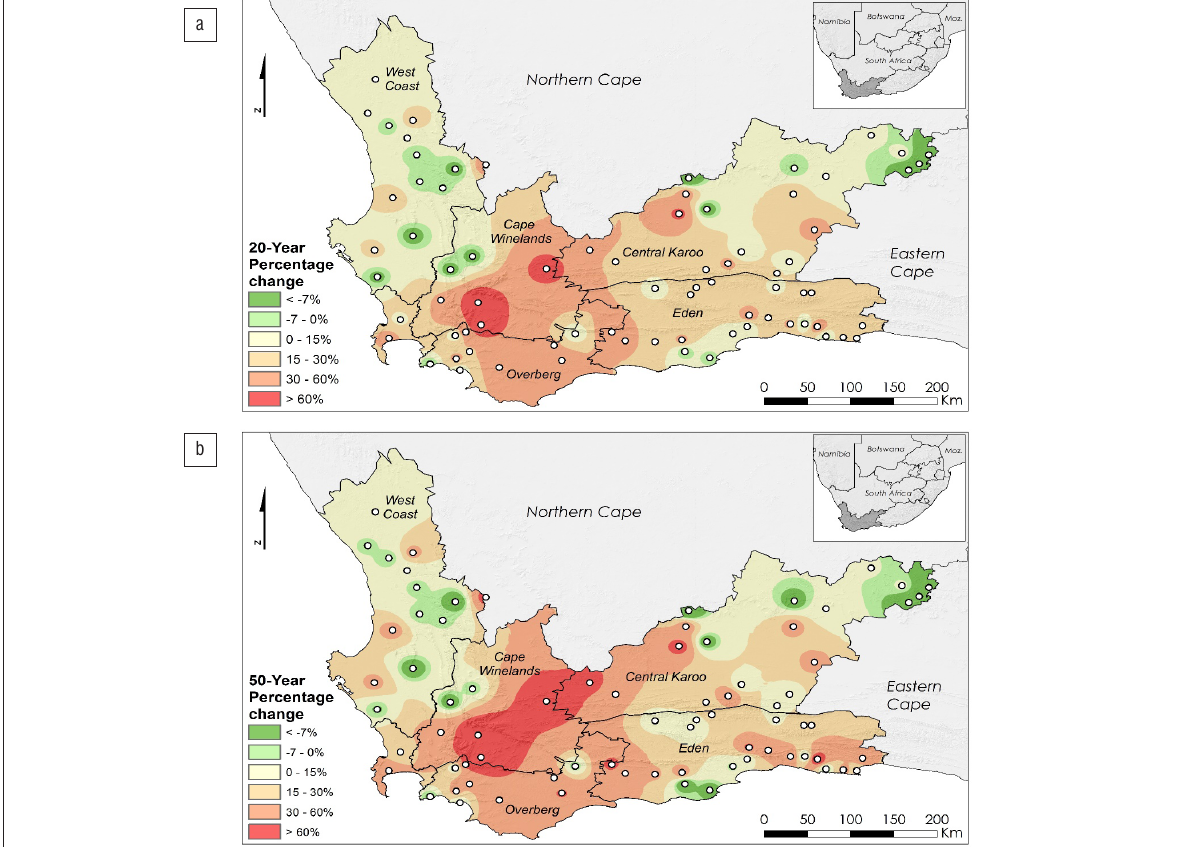
Figure 4: Inverse-distance-weighted interpolations of the (a) 20-year and (b) 50-year 1-day return period rainfall changes (%) above the 95th percentile threshold for the Western Cape from 1950–1979 to